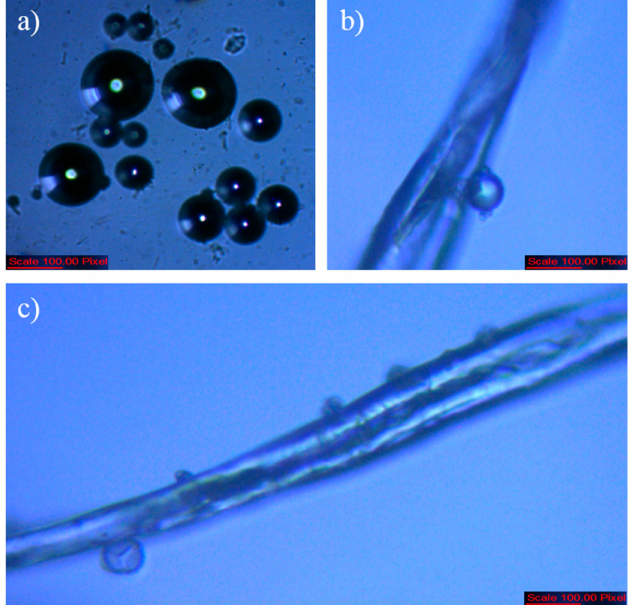
Figure 2. Optical photographs of ( a ) microcapsules solution ( b ) microcapsule on the cellulosic fiber surface and ( c ) a number of microcapsules throughout the length of the cellulosic